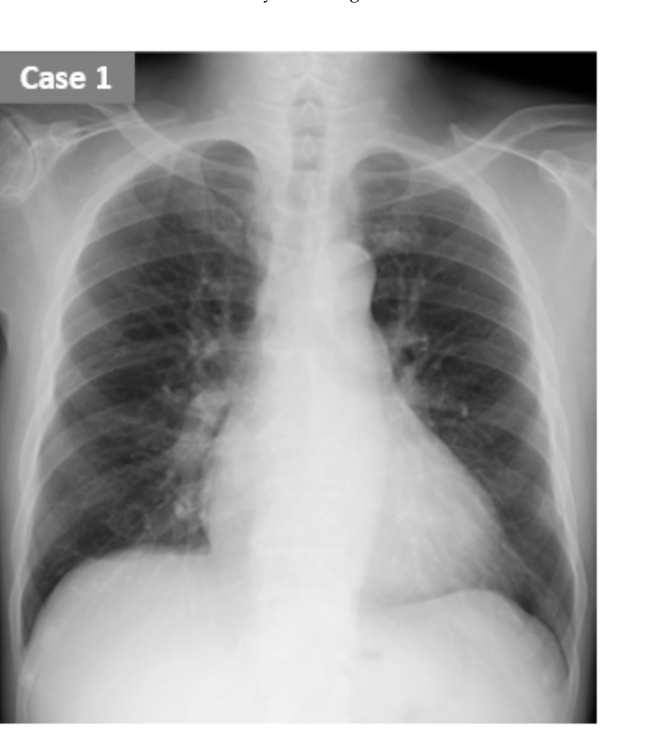
Figure 2. The chest X-ray just before hemodialysis in case 1. Index hemodialysis and ReDS measurement: The patient’s body weight decreased from 52.5 kg to 49.8 kg by 2.7 L of fluid removal. ReDS value decreased slightly from 32% to 30% (normal range: between 20% and 35%). Blood pressure trended from 128/80 to 113/72 mmHg (Figure 3). Echocardiographic inferior vena cava diameter (inspiratory/expiratory) trended from 7/9 mm to 2/0 mm. Hematocrit increased from 34.5% to 40.9%. The intradialytic plasma volume decrease was calculated as 15.6% [10]. Trends in other parameters are summarized in Table 2.